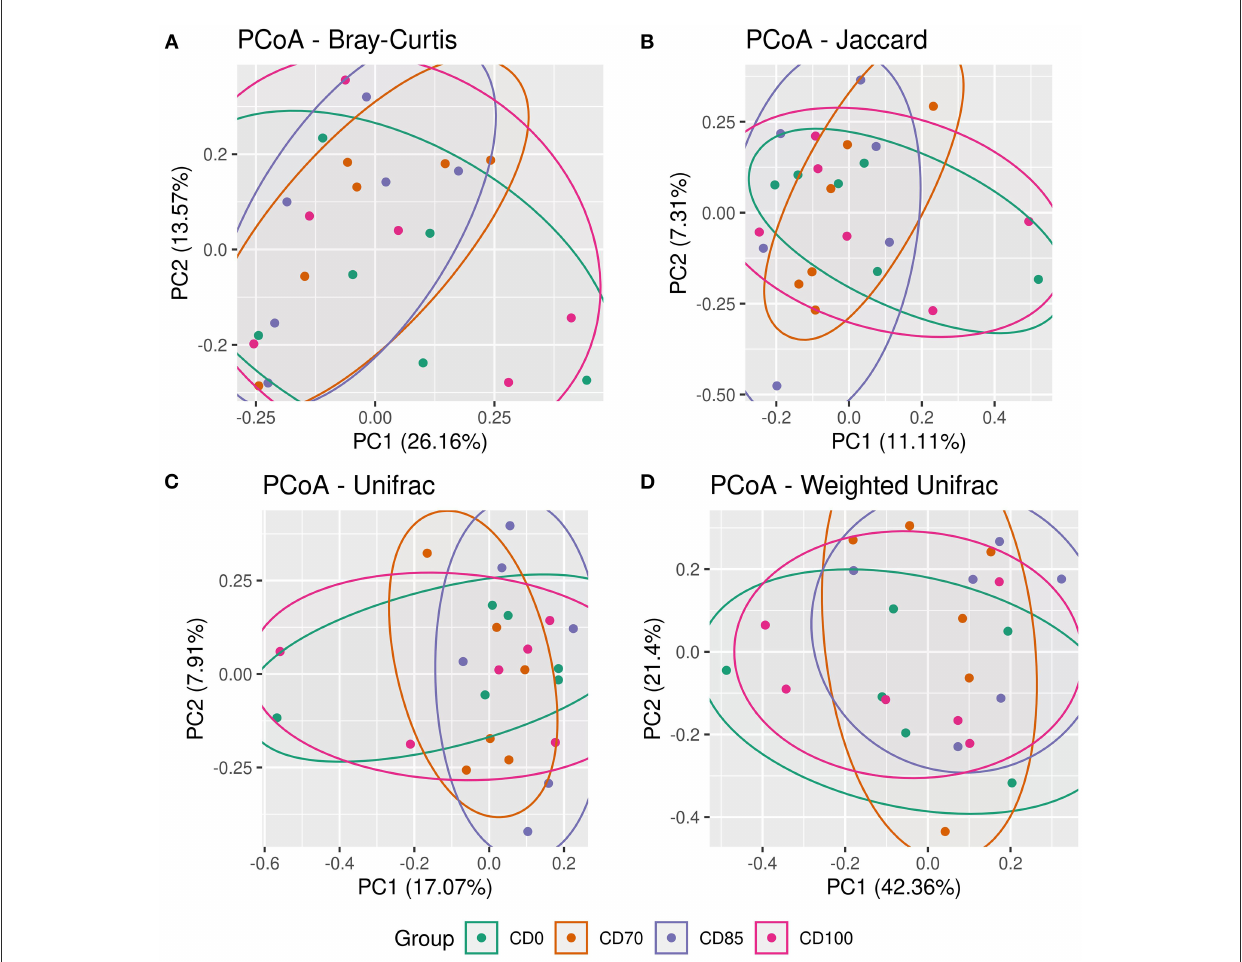
FIGURE2 Beta diversity estimated by parameters Bray-Curtis (A) , Jaccard (B) , Unifrac (C) , and Weighted Unifrac (D) in finisher pigs fed 1 of 4 dietary treatments: a control diet containing isolated phytase and xylanase valued at 40 kcal of ME/kg (CD0), CD0 + β -mannanase (0.3 g/kg valued at 30 kcal of ME/kg) (CD70), CD0 + β -mannanase (0.3 g/kg valued at 45 kcal of ME/kg) (CD85), and CD0 + β -mannanase (0.3 g/kg valued at 60 kcal of ME/kg) (CD100). Data are averages of 6 pigs per dietary